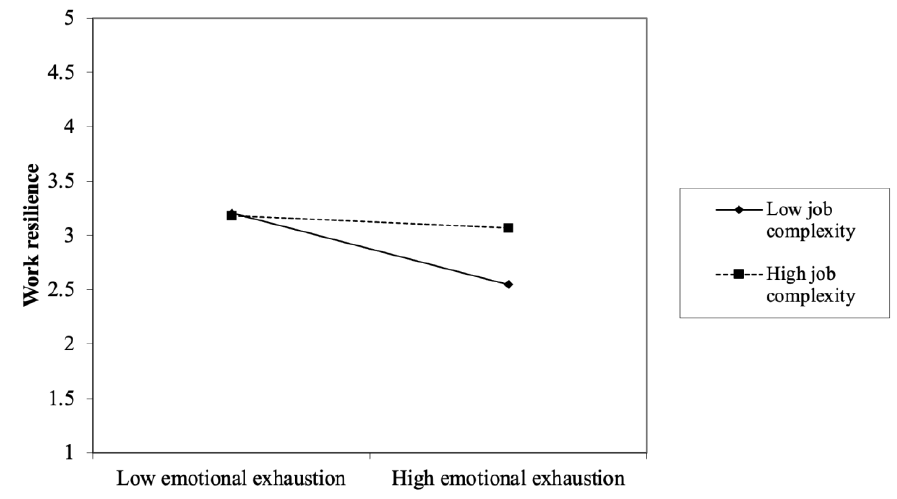
Figure 2. The moderating effect of job complexity.